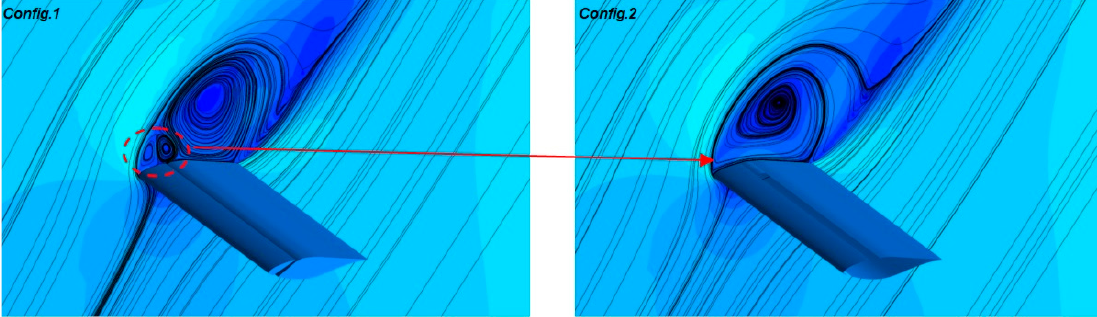
Figure 11. Streamlines and velocity distributions for configurations 1 and 2 compared to baseline at r/R